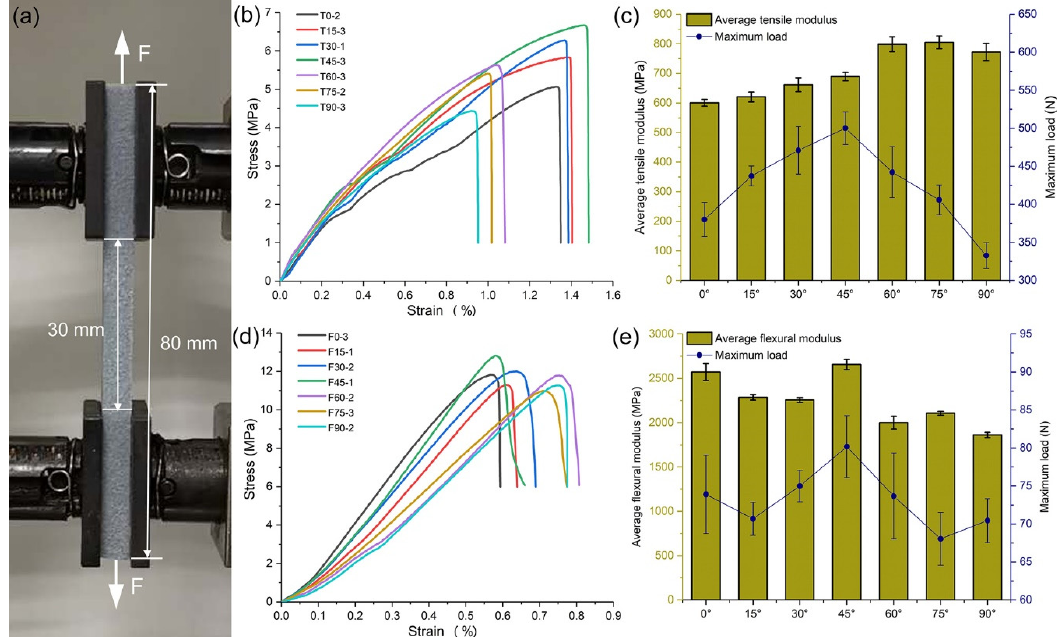
Figure 3. Mechanical tests at different printing angles: ( a ) Image of a uniaxial force stretched powder-based specimen; ( b ) Tensile stress-strain curves of a series of specimens; ( c ) Tensile-related properties measurements; ( d ) Stress-strain curves of three-point flexural test; ( e ) Bending-related properties measurements.